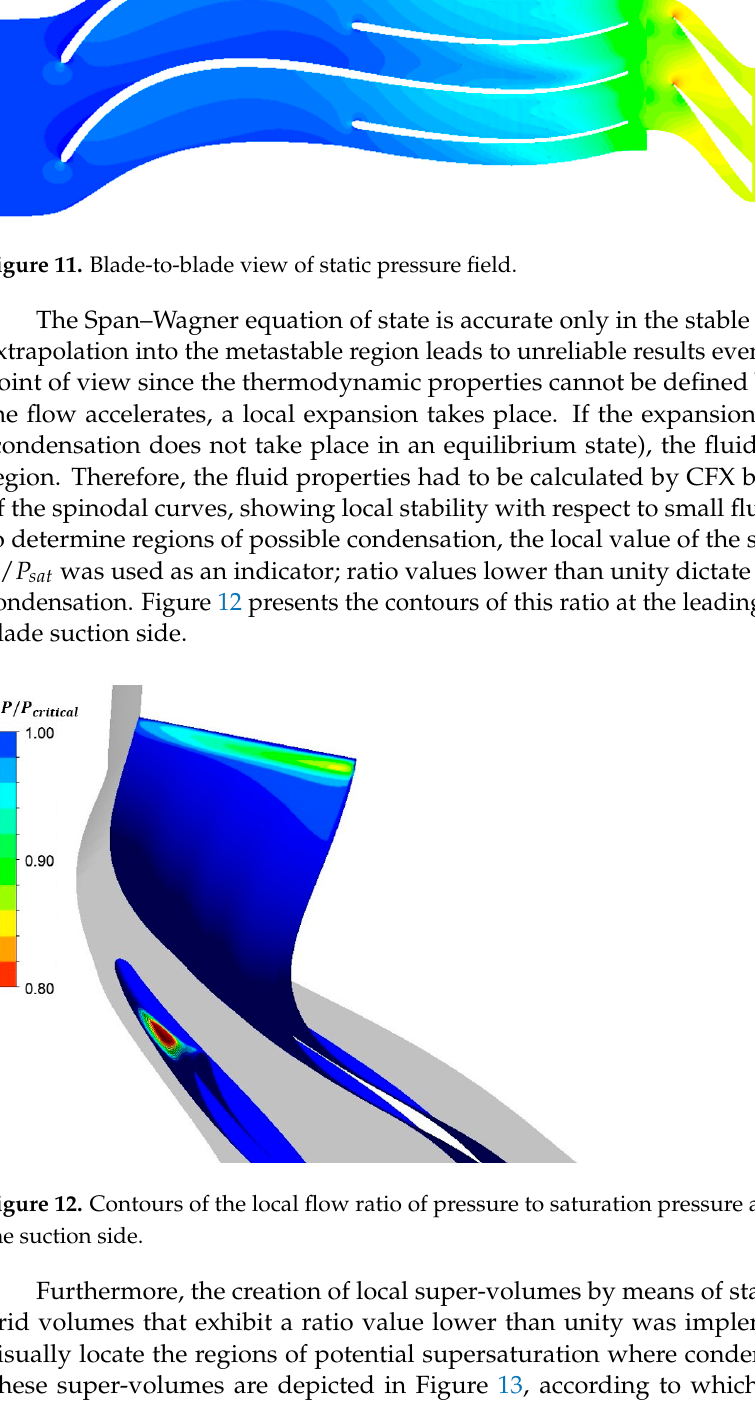
Figure 11. Blade-to-blade view of static pressure fi eld.